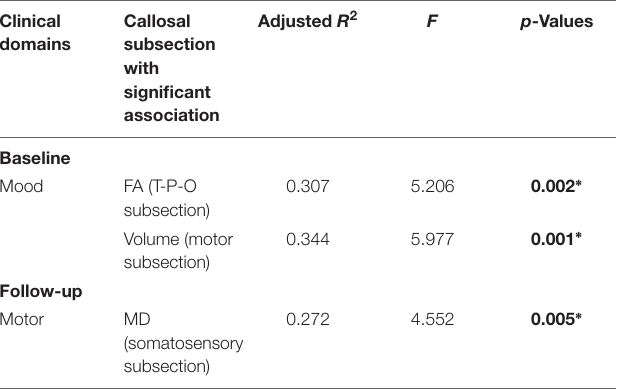
TABLE 4 | The significant results of regression